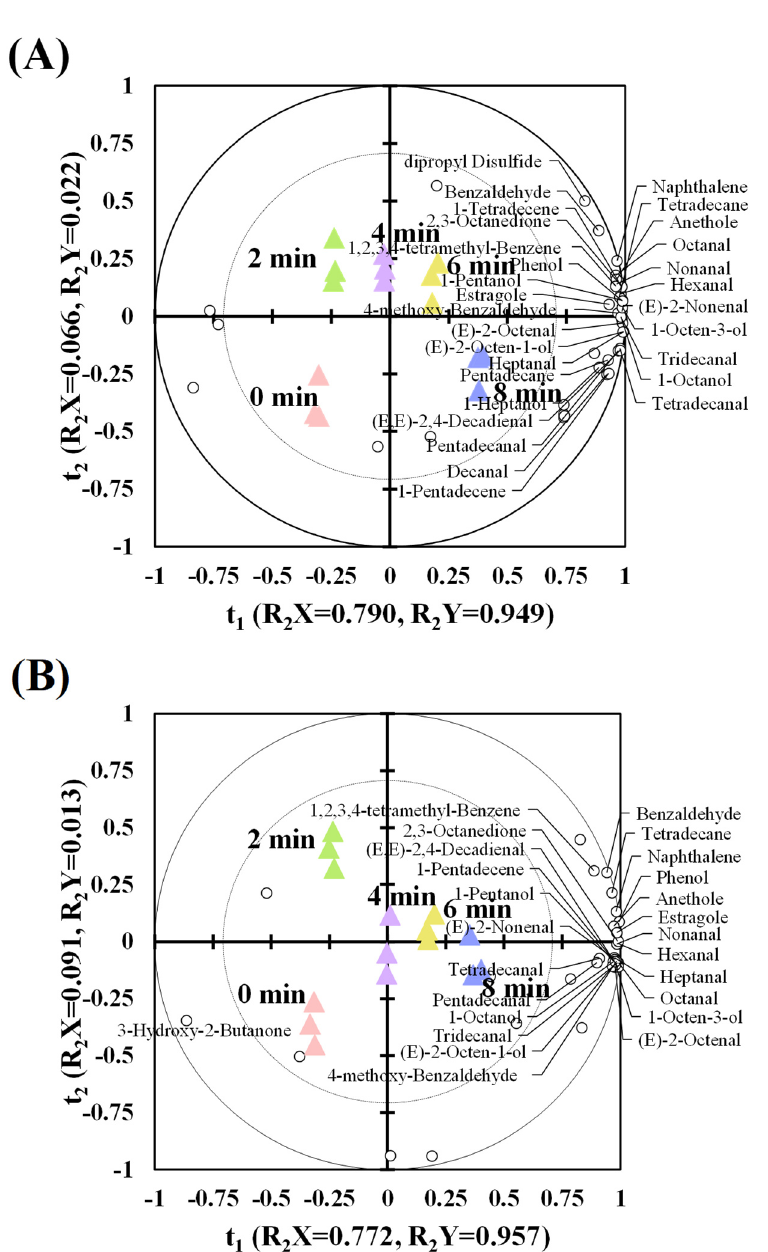
Figure 4. PLSR biplots showing the change of key volatile compounds in tamarix lamb roasted by charcoal ( A ) and electric ( B ) (triangle represented different roasting time, pink, green, purple, yellow, and blue represented 0 min, 2 min, 4 min, 6 min, and 8 min, respectively). Table 4. The volatile compounds with VIP >1 (markers) of tamarix lamb roasted by charcoal or elec- tric.